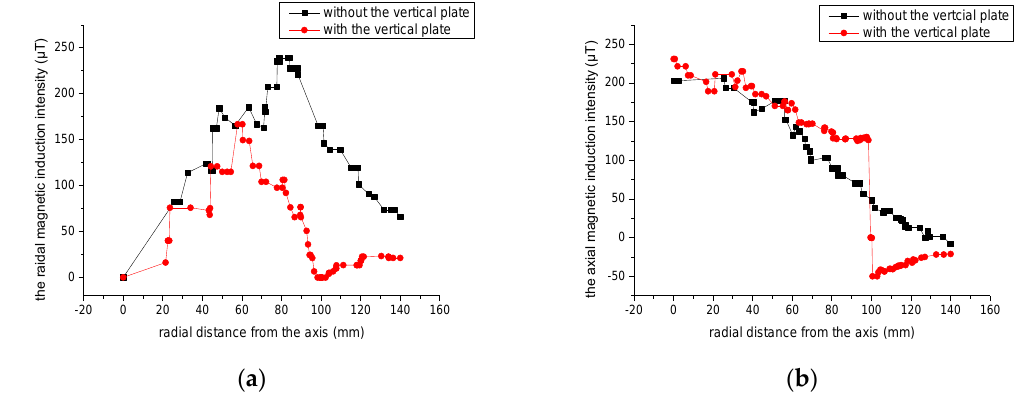
Figure 6. The variation of the magnetic induction intensity in the radial direction. ( a ) the radial magnetic induction intensity in the plane 50 mm from the transmitter coils; ( b ) the axial magnetic induction intensity in the plane 75 mm from the transmitter coils.